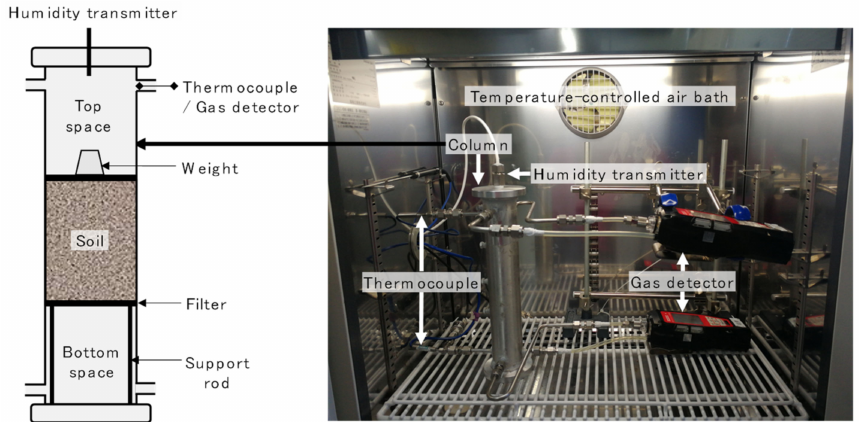
Figure 1. Experimental system for vertical vapor-phase diffusive transport of VOC through soil